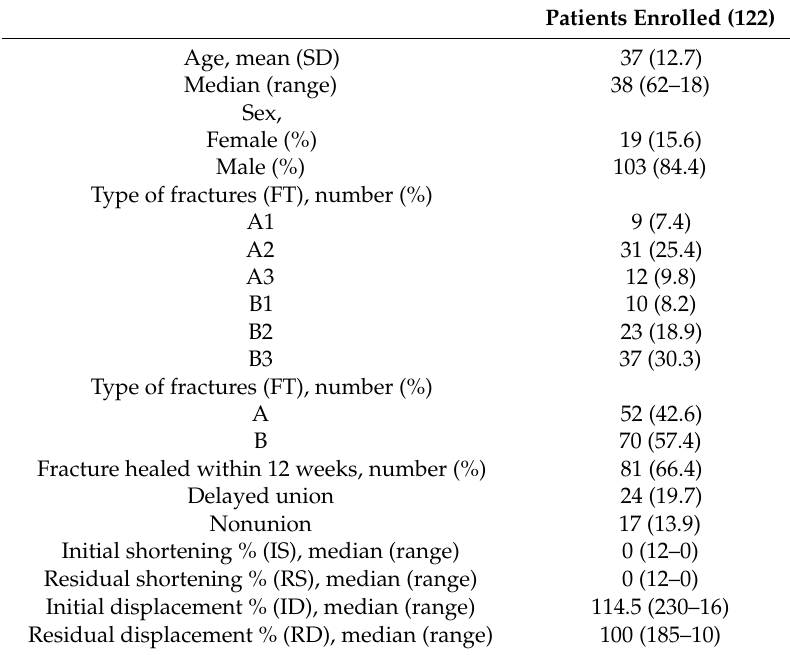
Table 1. Overall patient